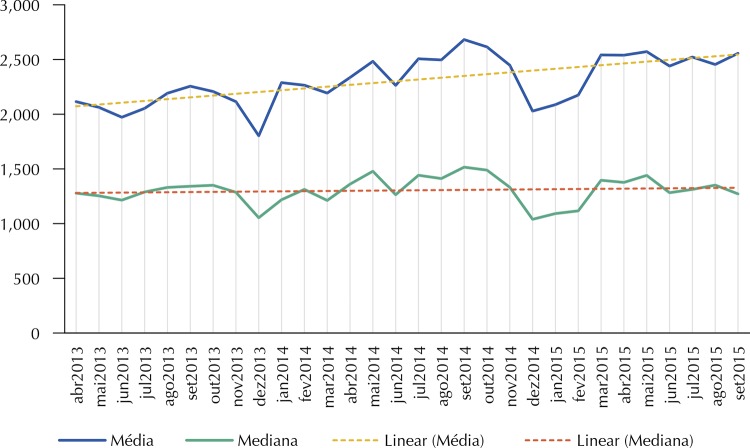
Média e mediana de consultas médicas mensais na Estratégia Saúde da Família em amostra de municípios participantes do programa Mais Médicos na região Nordeste, abril de 2013 a setembro de 2015.